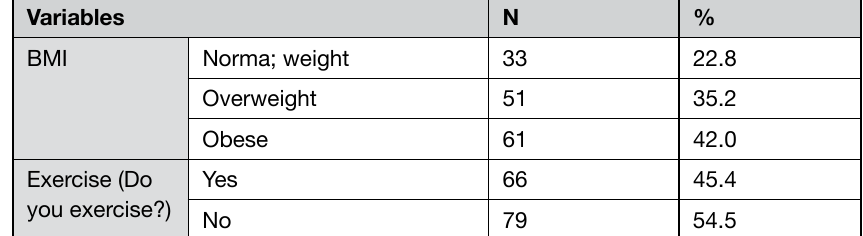
Table 2: Body mass index and exercise history of participants